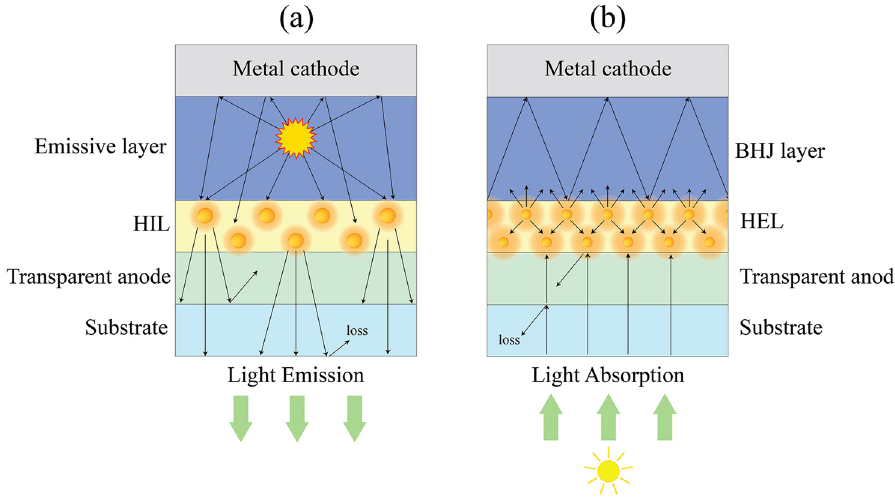
Figure 8: Schematic diagram of OLEDs and OPVs with plasmonic NPs, ( a ) NPs in HIL for OLEDs with scattering e ff ect and ( b ) NPs in HEL for OPVs with LSPR e ff